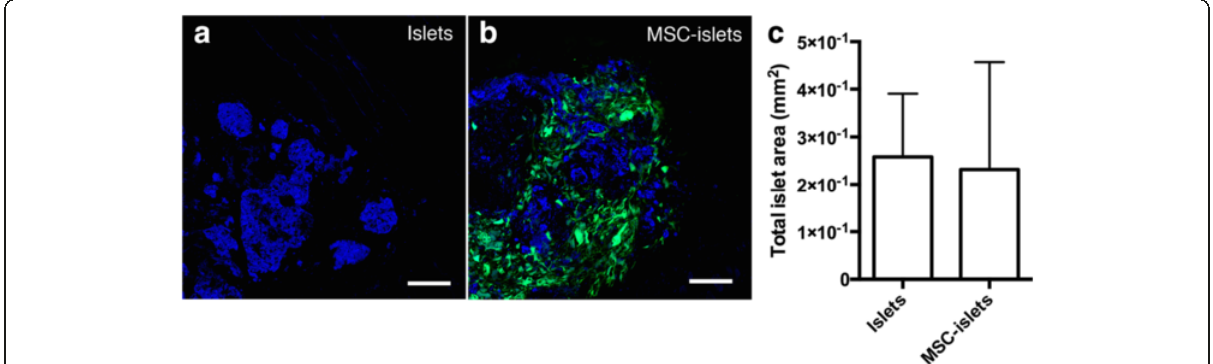
Fig. 2 Analysis of the islet graft size. a Control islet (blue) graft in the muscle tissue on day 7 post transplantation in comparison to ( b ) MSC-islet graft, where the islets (blue) are surrounded by MSC (green). c Quantification of the islet mass in the graft area of control islets and MSC-islets. Bars = 100 um